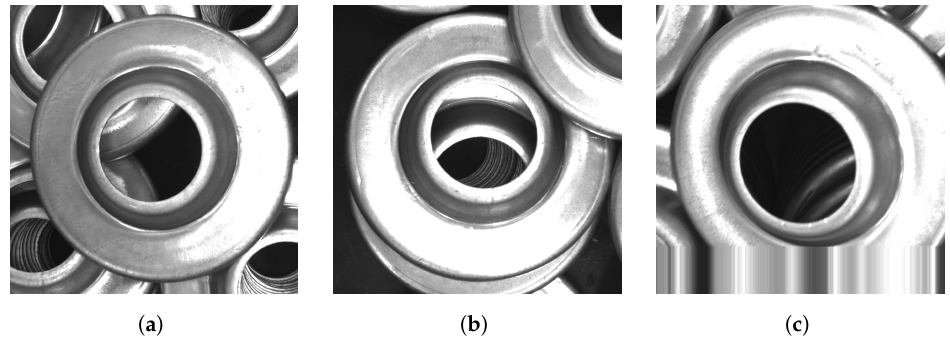
Figure 14. Example cases for part occlusion. ( a ) Unoccluded part. ( b ) Occluded part. ( c ) Unclear occlusion